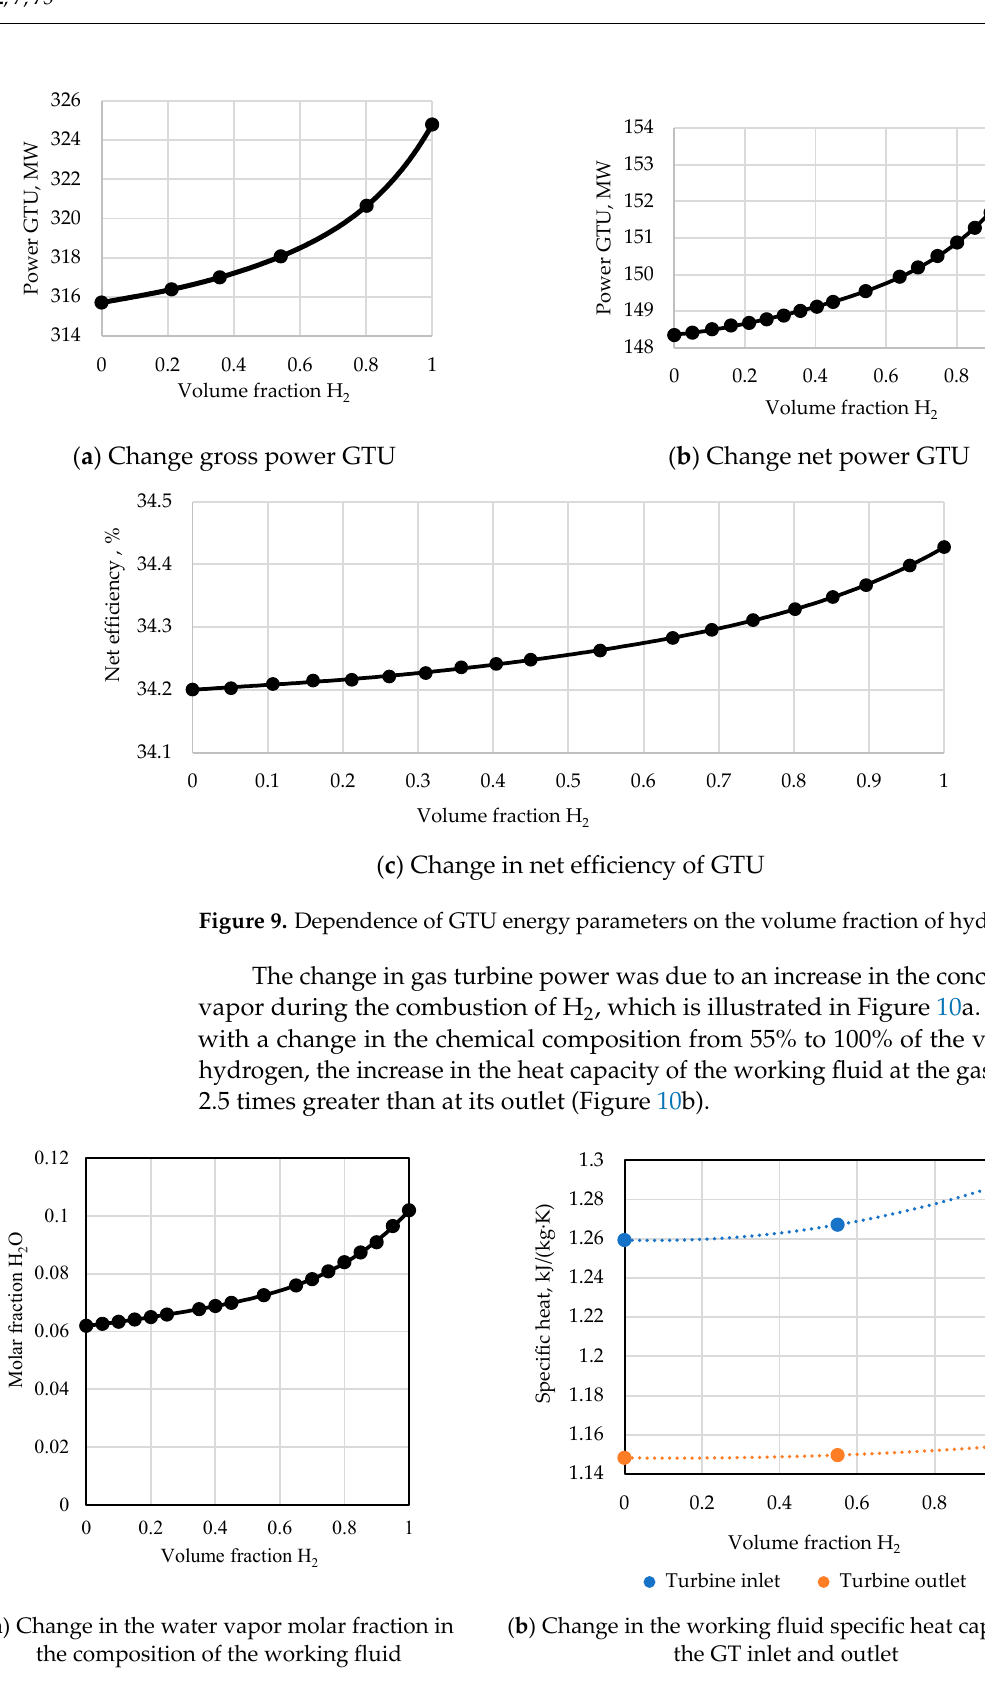
Figure 8. The influence of the volume fraction of hydrogen on the performance of gas turbines. The minimum of the Wobbe index curve is associated with the low density of hydro- gen, due to which with an increase in the volume fraction of hydrogen above 80%, an ear decrease in fuel density (Figure 9b).